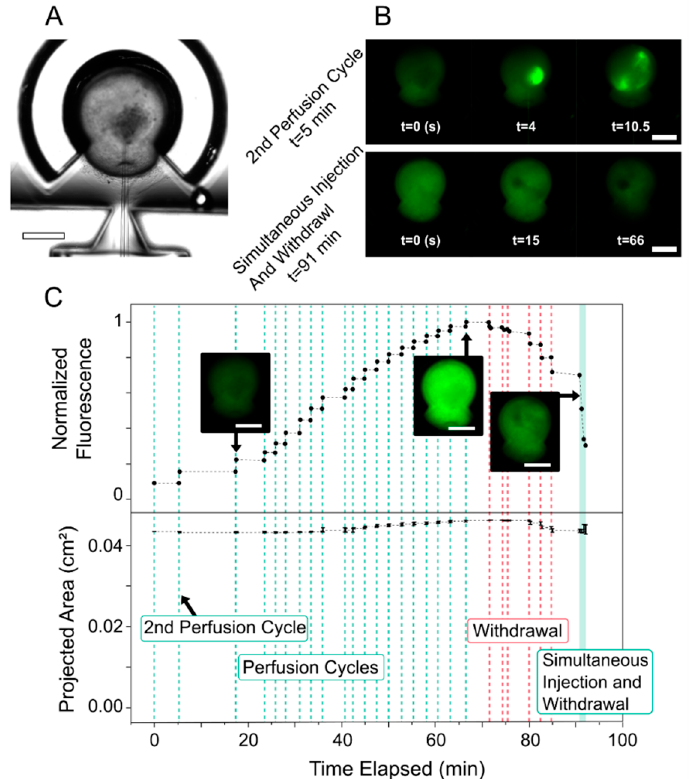
Figure 2. ( A ) Brightfield image of a punctured HIO in a PDMS holder. Scale bar: 1 mm. ( B ) Towards demonstrating convective mixing, selected fluorescence images are shown from near the beginning (t = 5 min) and end (t = 91 min) of the experiment. The second perfusion cycle shows injection (t = 4 s) and withdrawal (t = 10.5 s), whereas the simultaneous injection and withdrawal (constant perfusion) shows more homogenous decrease in fluorescence over time. Scale bars: 1 mm. ( C ) Normalized fluorescence (with respect to the maximum value) and HIO projected area plotted with time. The mean values of three separate fluorescence measurements are plotted as dots. The standard deviation for each timepoint was <0.004, so error bars are not visible on the graph. On the lower half of the graph, ± 1 standard deviation of the projected area is plotted. Applied perfusion cycles are shown with green dotted lines, perfusion cycles consisting of only withdrawal are shown with red dotted lines, and constant simultaneous injection and withdrawal is shown in the green shaded region. Note: fluorescence before the first perfusion cycle is not included. Plotted data is for one